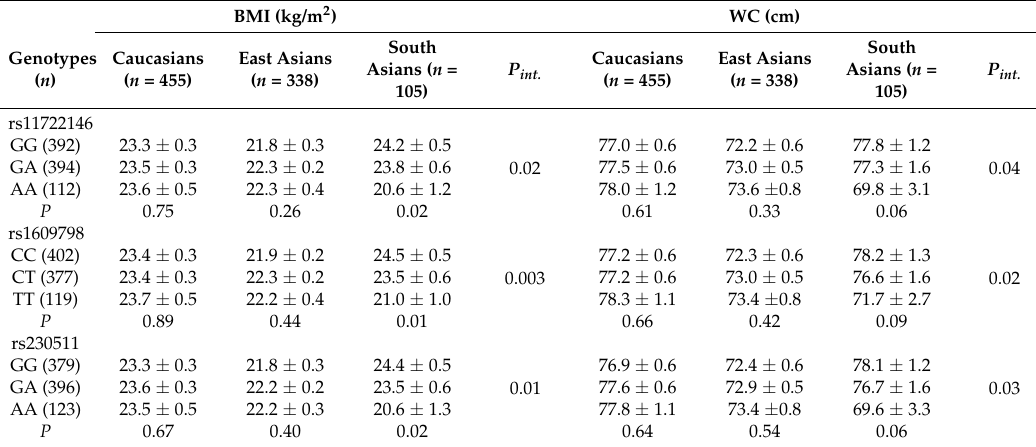
Figure 1. Interactions between the plasma lower (black—below the median) and higher (grey—above the median) n-6/n-3 ratio groups and racial/ethnic groups on BMI ( p = 0.02) and WC ( p = 0.007). P for interactions for differences in BMI or WC between racial/ethnic groups were tested using a general linear model adjusted for caloric intake, physical activity, age, and sex. Abbreviations: BMI, body mass index; WC, waist circumference. Table 2. Interactions between NFK1B rs11722146, rs1609798, and rs230511genotypes and racial/ethnic groups on anthropometric traits ( n = 898). BMI (kg/m 2 ) WC